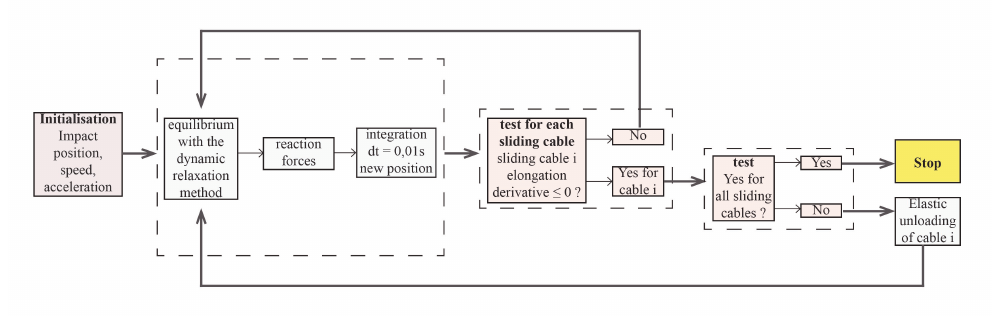
Figure 8. Equivalent spring-mass dynamic algorithm of the